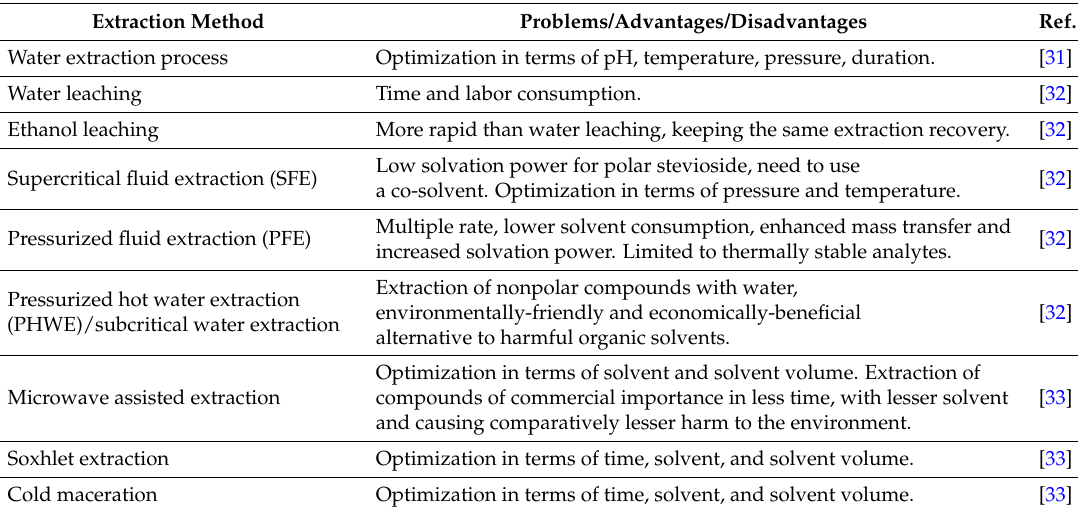
Table 1. Different extraction methods of steviosides from air dried crushed leaves of S . rebaudiana . Extraction